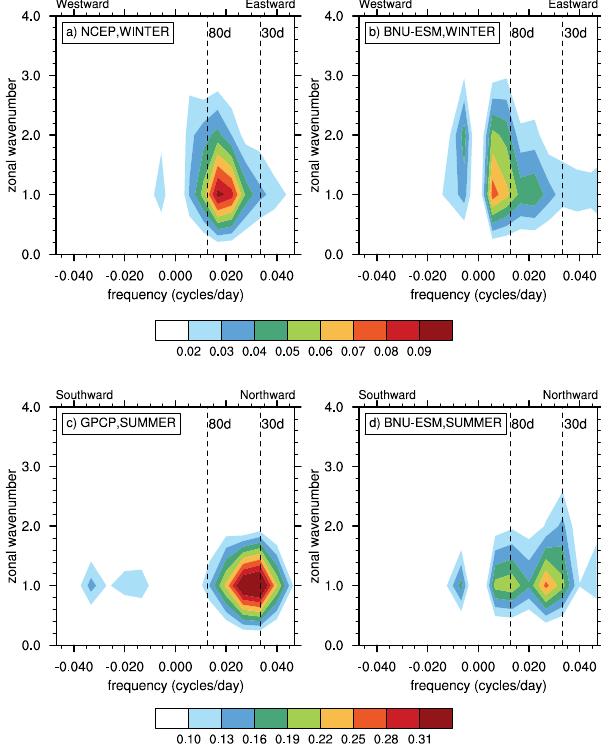
Figure 15. November–April wavenumber-frequency spectra of 10 ◦ S–10 ◦ N averaged daily zonal 850hPa winds for NCEP ob- servation (a) and BNU-ESM (b) . May–September wavenumber- frequency spectra of 15 ◦ S–30 ◦ N, 65–95 ◦ E averaged daily pre- cipitation for GPCP observation (c) and BNU-ESM (d) . Individ- ual spectra were calculated for each year and then averaged over all years of data. Only the climatological seasonal cycle and time mean for each November–April or May–September segment were removed before calculation of the spectra. The averaging period is 1980–2005 for BNU-ESM historical run, and 1997–2006 for obser-